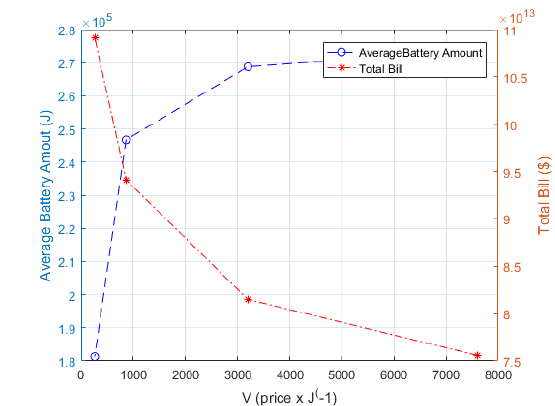
Figure 4. Average battery amount and total bill vs. V